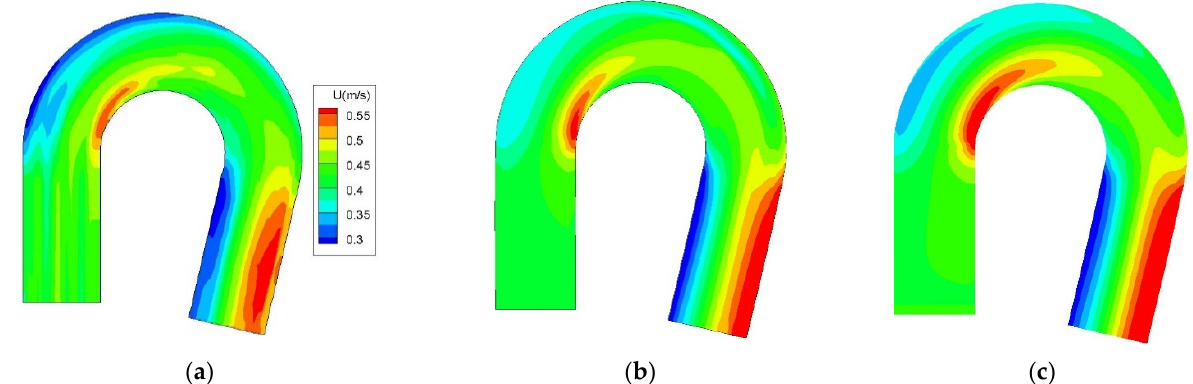
Figure 6. Distribution of depth-averaged stream-wise velocity: measured ( a ), computed ( b ), and computed on the refined grid ( c ).